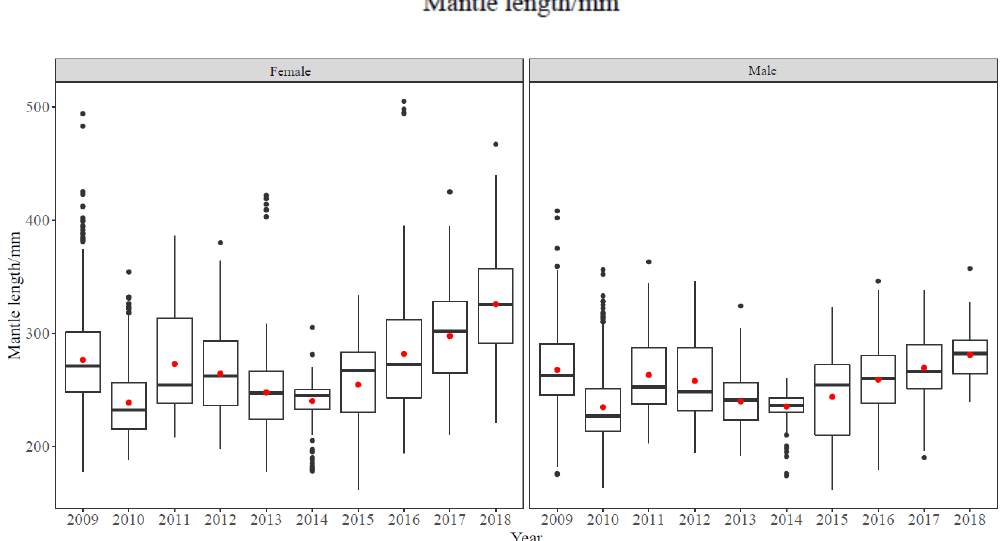
Figure 3. Distribution of mantle length of O. bartramii in different years. The boxes show the median and the interquartile range. The black dots are indications of outliers in the data. The red dots show the mean.